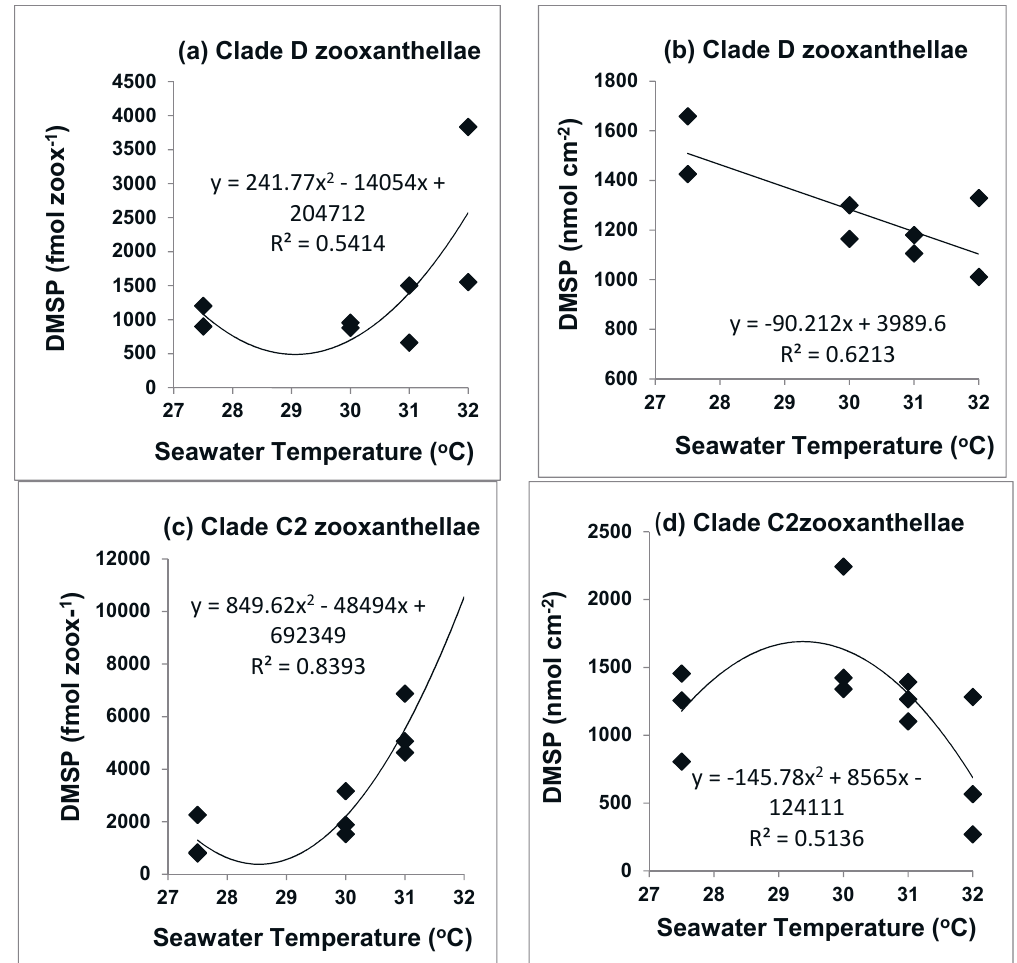
Figure 5. Change in cellular (fmol zooxanthellae − 1 ) and areal (nM cm − 2 ) DMSP concentrations in ( a ) Acropora millepora clade D colonies from Magnetic Island and ( b ) Keppels Transplant colonies; and in clade C zooxanthellae in ( c , d ) from Keppels, Davies and Davies Transplant colonies at different seawater